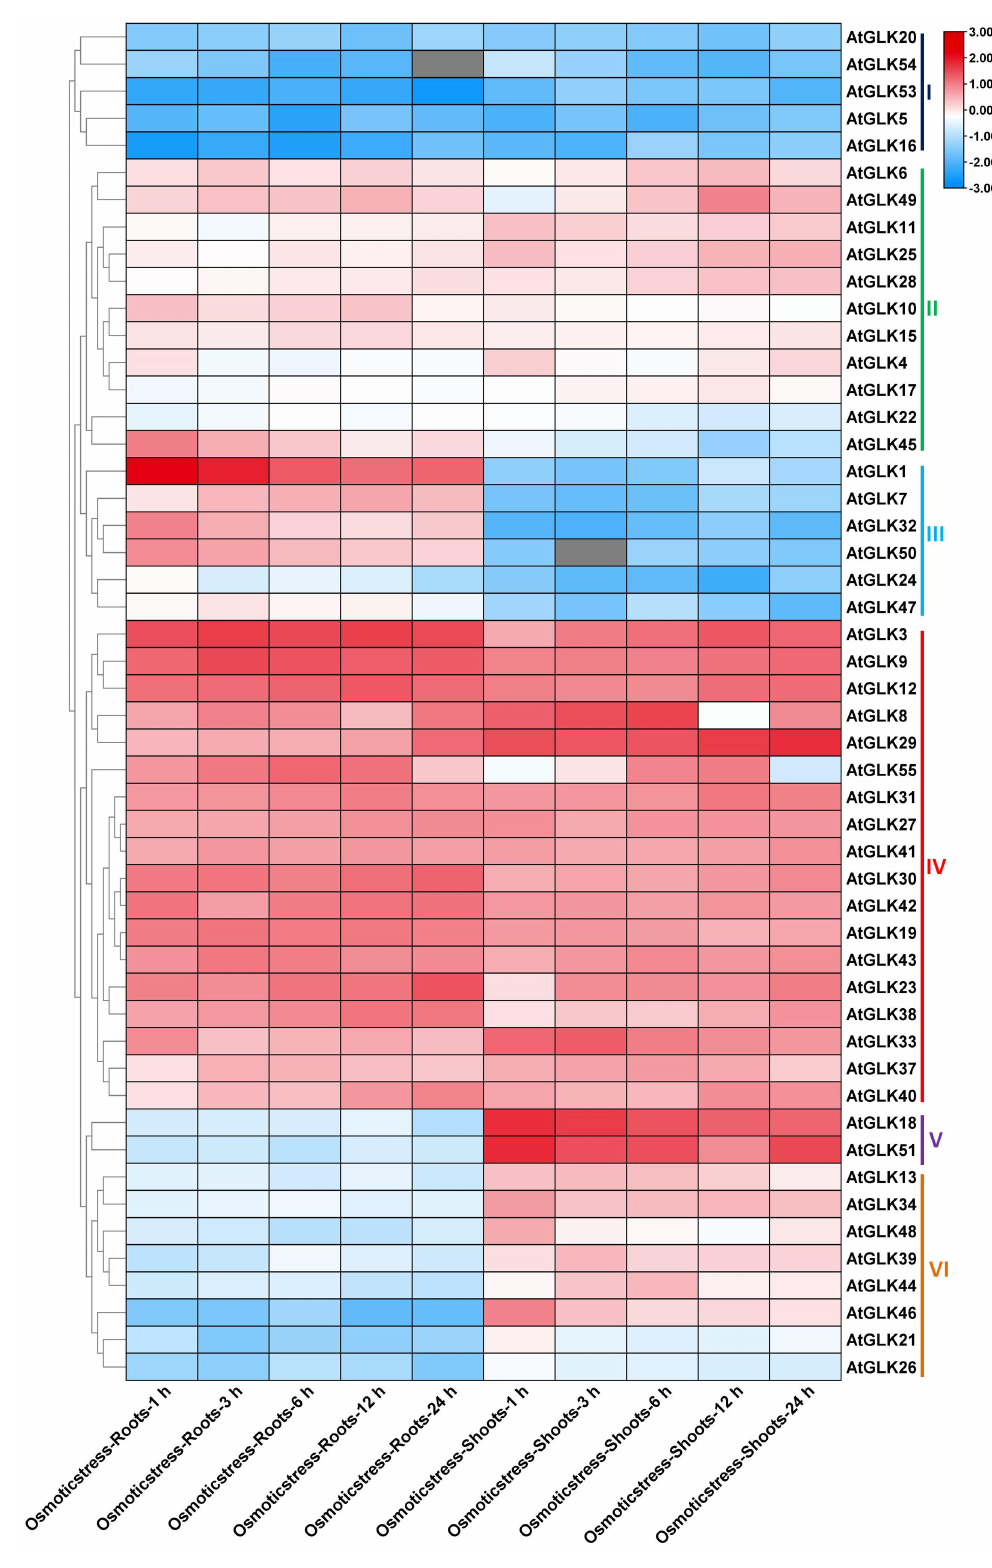
Figure 7. The expression of AtGLK genes in roots and shoots under osmotic responses. Heatmap generated from microarray experiments. Treatments and replicate numbers were determined by Kilian et al. [36]. Two biological replicates’ intensity values were pooled and normalized following the control treatment (treatment/control) in the heatmap. Control roots and shoots represent non-stressed tissue. The red and the blue intensities show high and low expression levels,